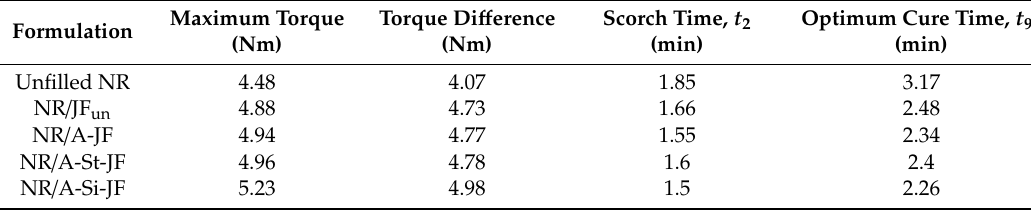
Figure 5. Cure curves of unfilled and JFs filled natural rubber (NR) composites. Table 2. Cure properties of NR composites.